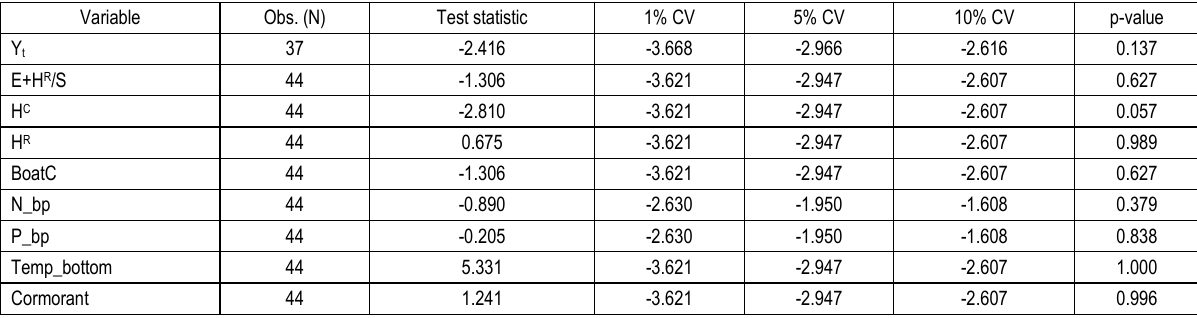
Table A1. Results of the augmented Dickey-Fuller unit root test for the regression variables.